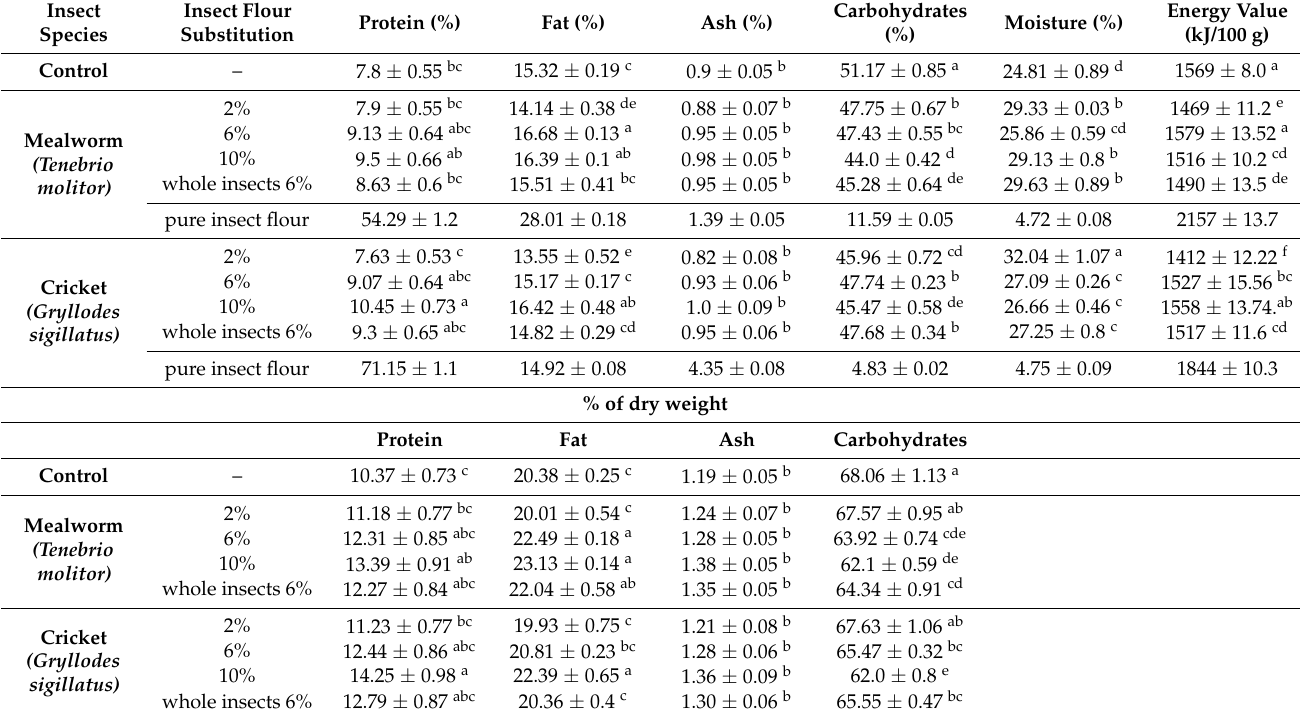
Table 1. Nutritional value of